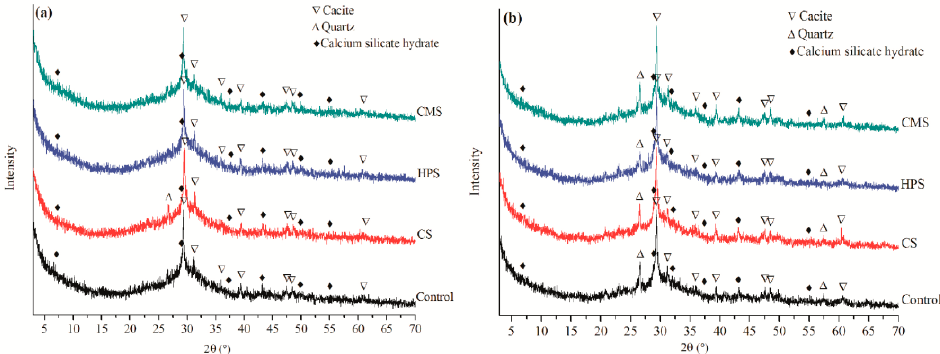
Figure 5. XRD patterns of 85 °C-cured ( a ) and 200 °C-heated ( b ) specimens of control and AAC with 3% starches.